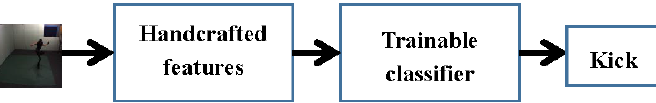
Figure 2. Example of handcrafted representation ‐ based approach.